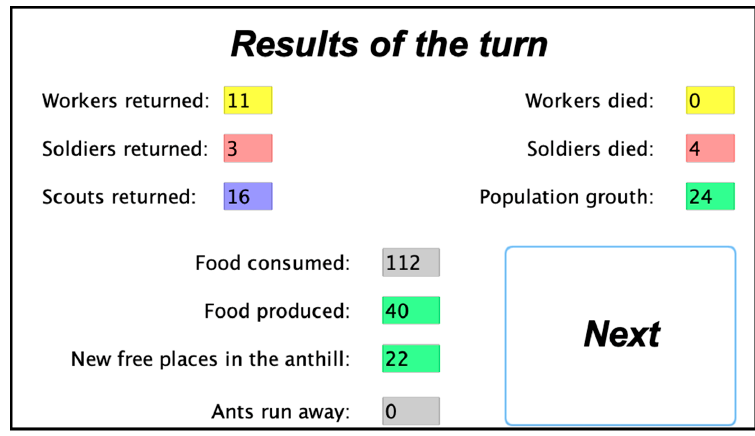
Figure A2. The feedback window.